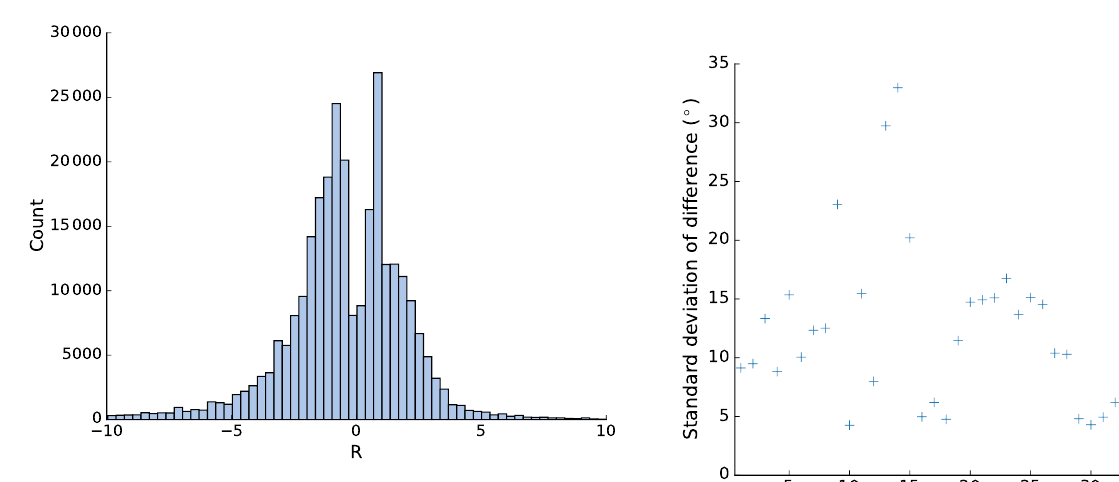
Figure 17. The diurnal mean angle difference.